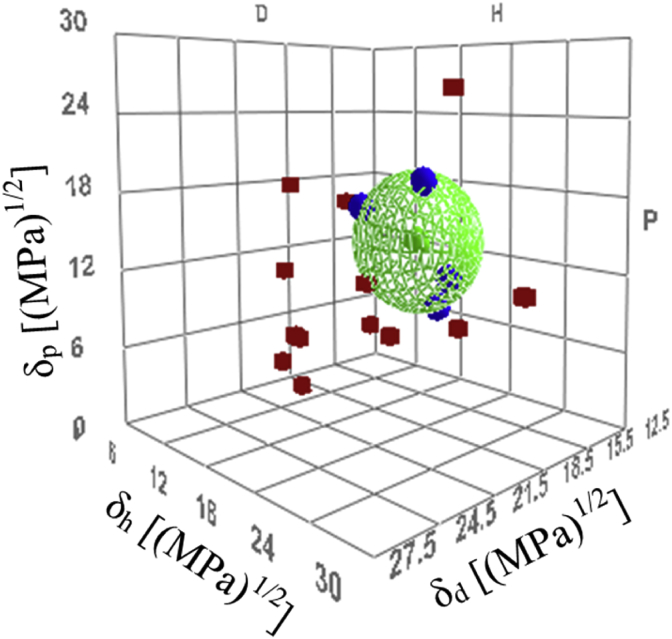
HSP 3D diagram of Silica particles with HSPs of organic solvents used in this work. Blue balls are “good” solvents, and red cubes are “poor” solvents.